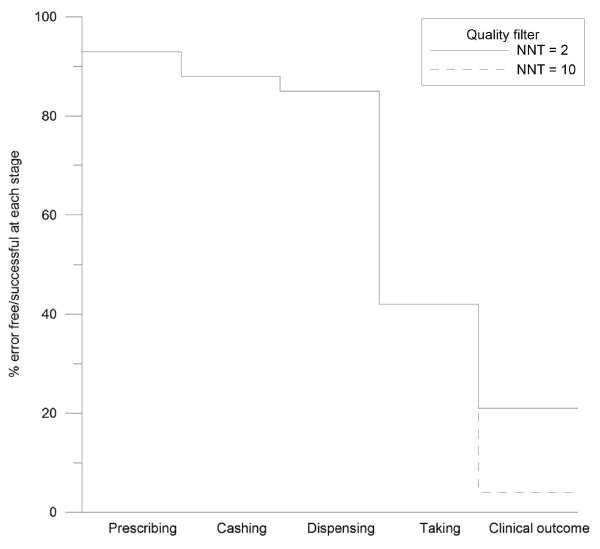
Quality filter map.